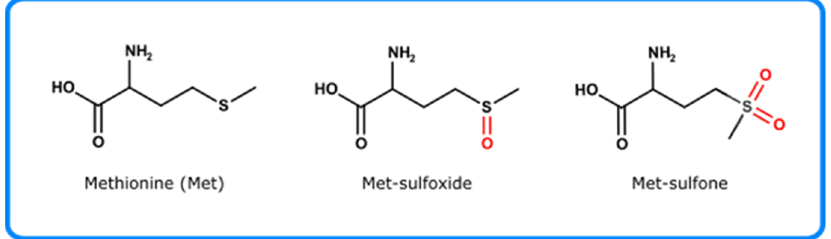
Figure 4. Chemical structures of Methionine and common Methionine photo-oxidation products such as Met-sulfoxide and Met-sulfone. Table 8. Analytical techniques/assays to detect Met oxidation products with the corresponding analytical techniques and relevant references.